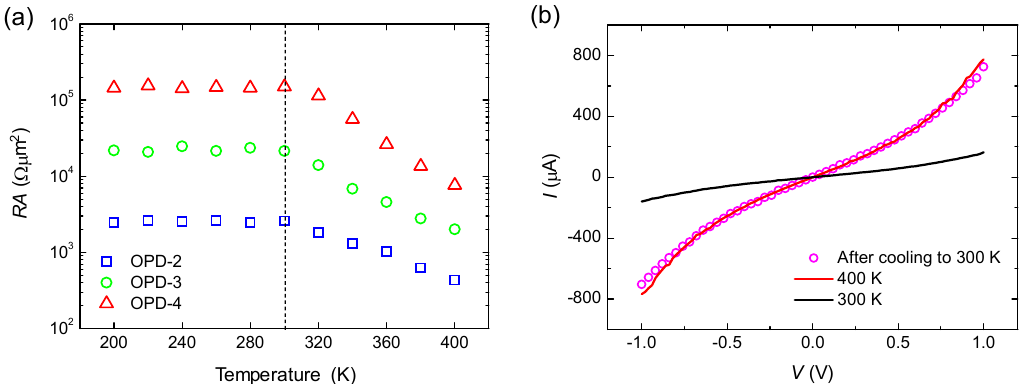
Figure 2. ( a ) Semilog plots of RA versus temperature for OPD- n junctions at different annealing temperatures (300, 340, and 380 K). A vertically dashed line indicates 300 K. ( b ) Irreversible I ( V ) characteristic of OPD-4 junction after thermal annealing at 400 K.